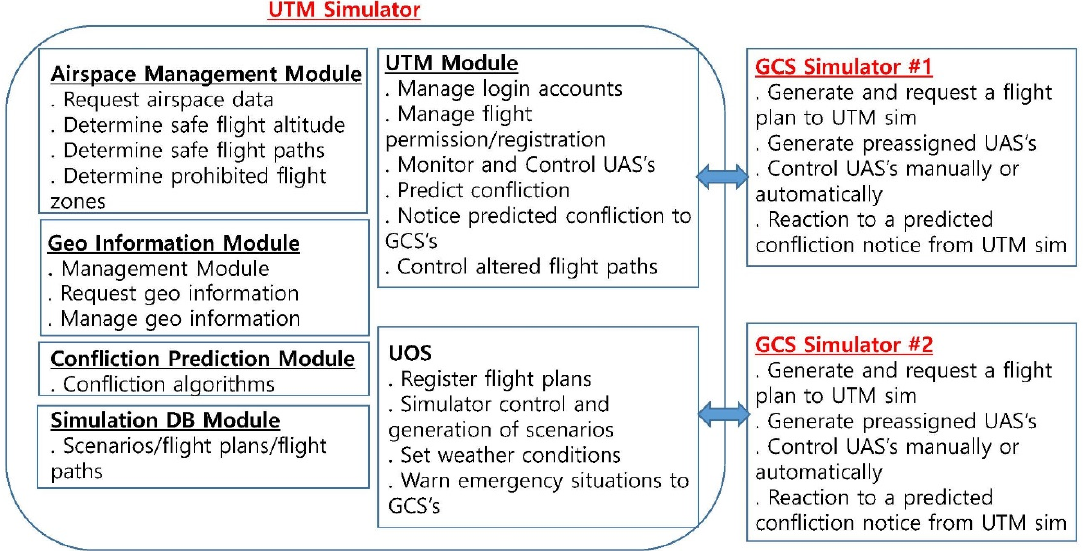
Figure 1. Functions of eUTM (UAS Traffic Management) simulator.